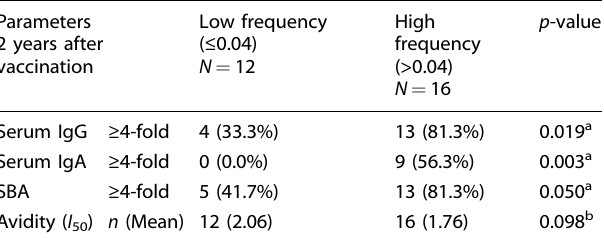
Table 2. Frequency of speci fi c-IgG memory B-cells at 3 months post- last vaccination (with 2 or 10 µg OS doses of non-adjuvanted and adjuvanted SF2a-TT15) de fi ned as “ low ” and “ high ” values around the geometric mean, and percent of responders ( ≥ 4 fold) for serum IgG, serum IgA, SBA and mean value for avidity against SF2a LPS, 2 years after vaccination. Parameters 2 years after